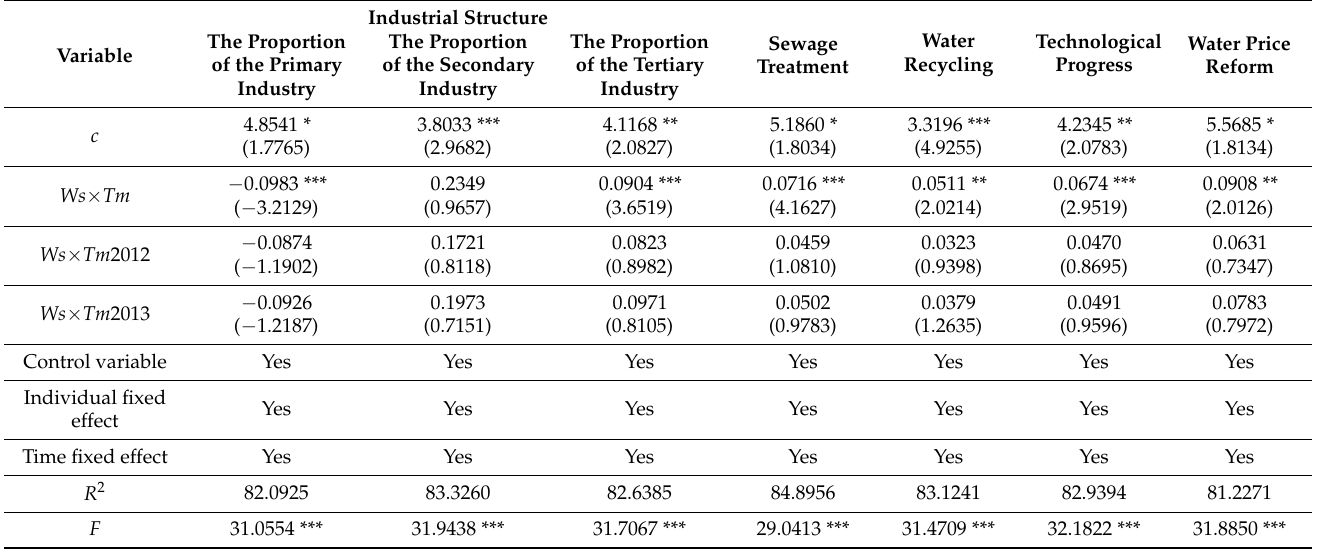
Table 5. Estimation results of the impact of pilot policies on mechanism variables.